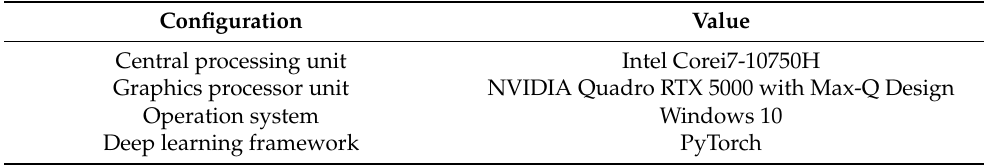
Table 2. Software and hardware